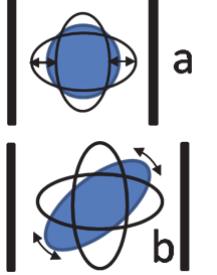
Fig. 7: (a) Evenly polarizable objects always attract one another (compare to charges in Figure 2) leading to the formation of pairs or pearl-chains. (b) Elongation and compression according to Figure 2a and b translate into positive or negative DP, i.e. movement of the object towards high and low field, respectively. (c) Strongly inhomogeneous fields can be used for the collection of submicro-objects or field